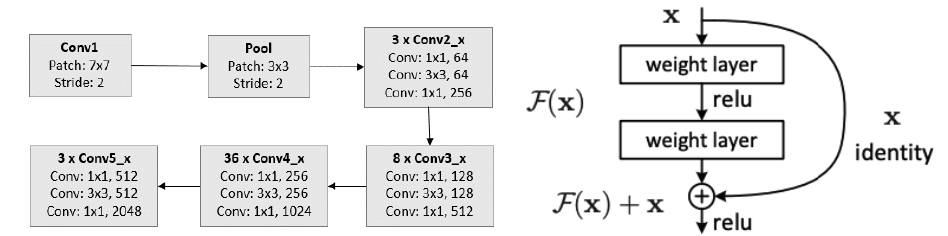
Figure 5. The basic architecture of Resnet152 ( left , from [48]), and the building block for the residual learning ( right , from